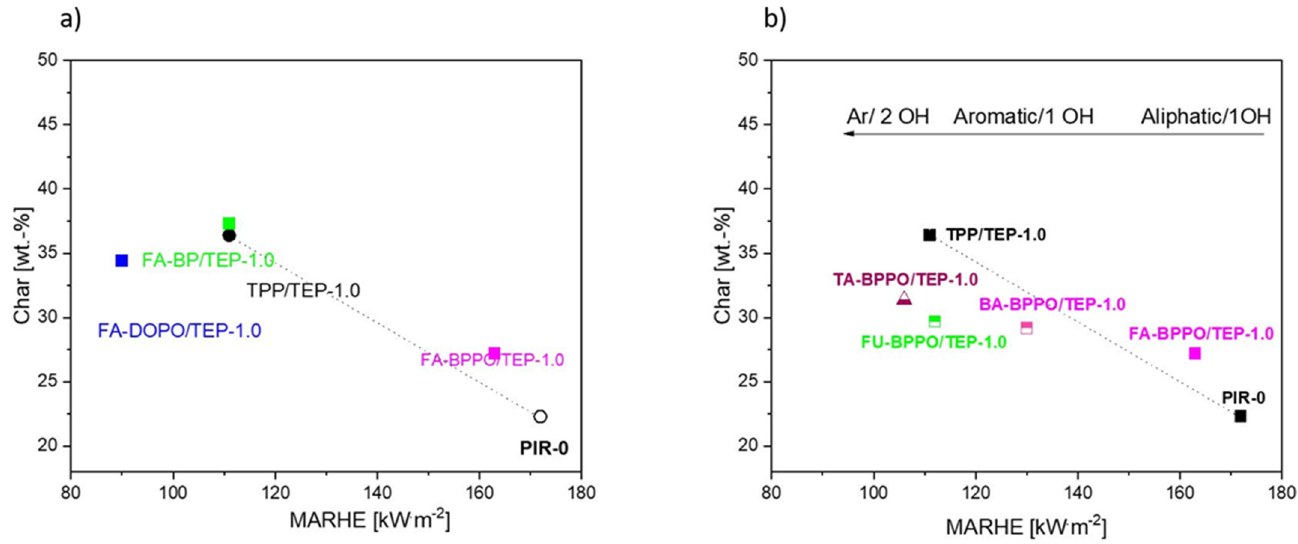
Figure 5. MARHE vs. char plot of ( a ) PIR foams with reactive formaldehyde (FA)-based additives and ( b ) PIR foams with reactive phospha-aldol adducts.